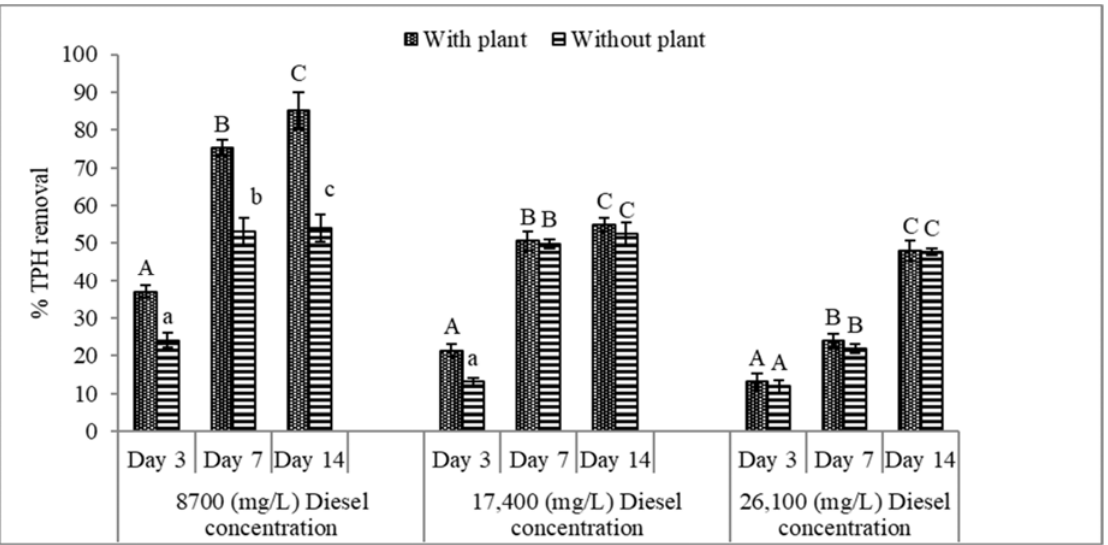
Fig. 6. TPH degradation by Salvinia molesta with: (a) 8,700 mg/L diesel (b) 17,400 mg/L diesel, and (c) 26,100 mg/L diesel. A, a: means significant different between treatments (with and without plants) at p < 0.05; AA: not significant different between treatments (with and without plants) p >